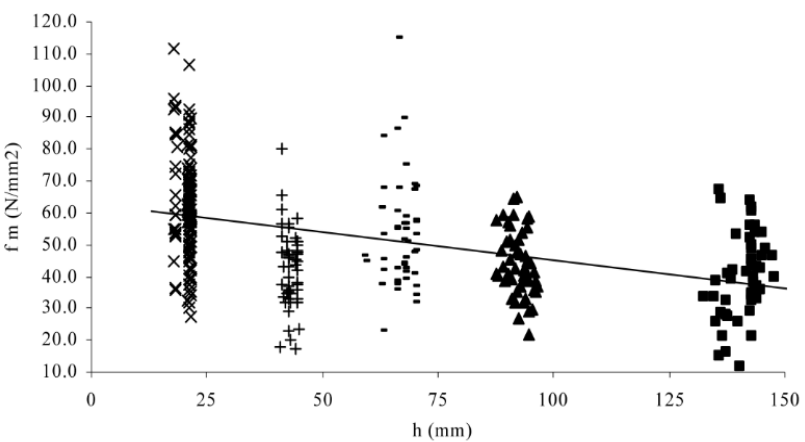
Figure 29. Plot of bending strength, f m , against specimen depth, h, of for 349 specimens. Note the high degree of scatter relative to variation in mean value between values of h. From [130]. The dif- ferent symbols distinguish between specimens of different sizes.